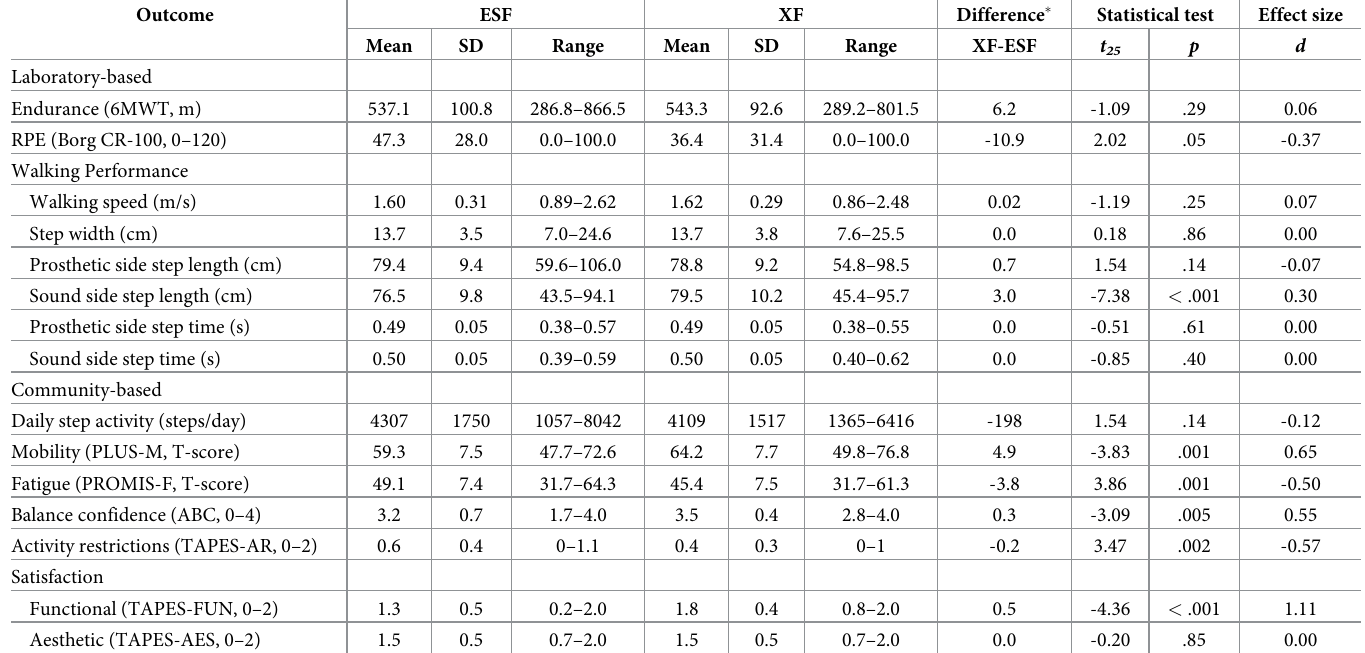
Table 2. Results of clinical performance and self-report measures (n =